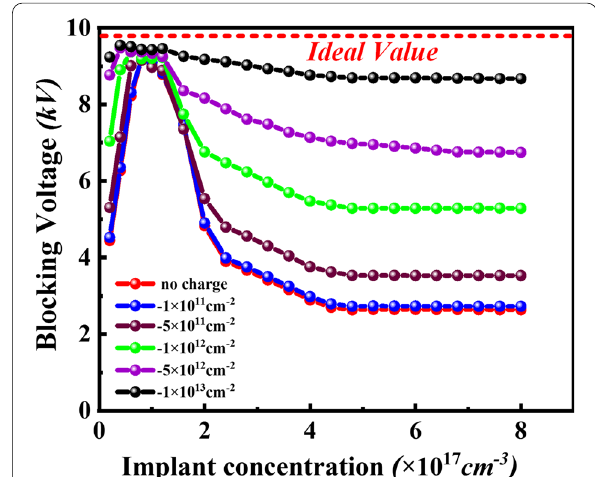
Fig. 4 Simulated breakdown voltage versus JTE implant concentration for surface negative charge, including no charge, 1 10 11 cm − 2 , 5 10 11 cm − 2 , 1 10 12 cm − 2 , 5 10 12 cm − 2 , and × × × × 1